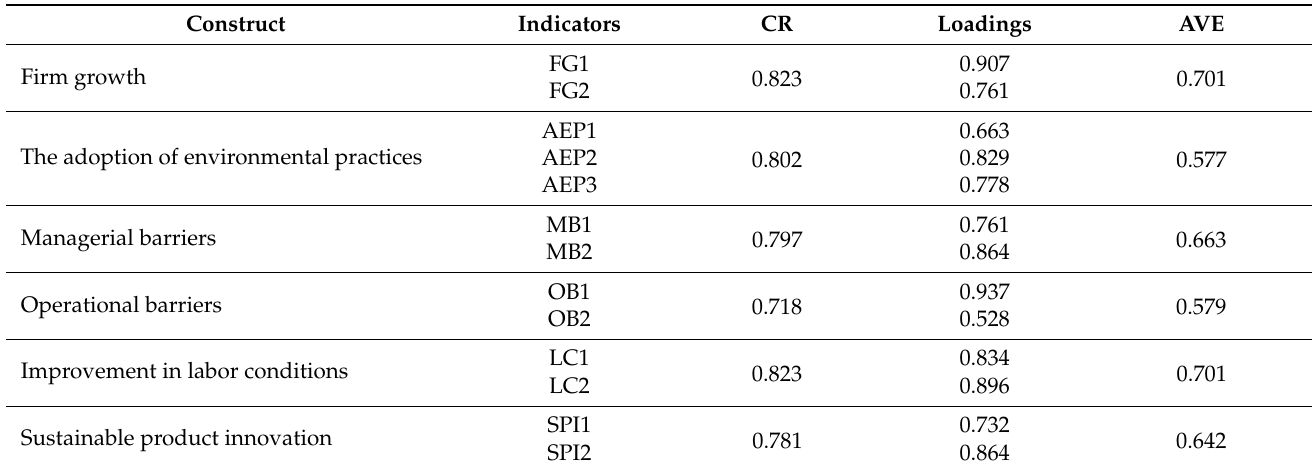
Table 2. Item loadings, average variance extracted (AVE), and composite reliability (CR) assessment.